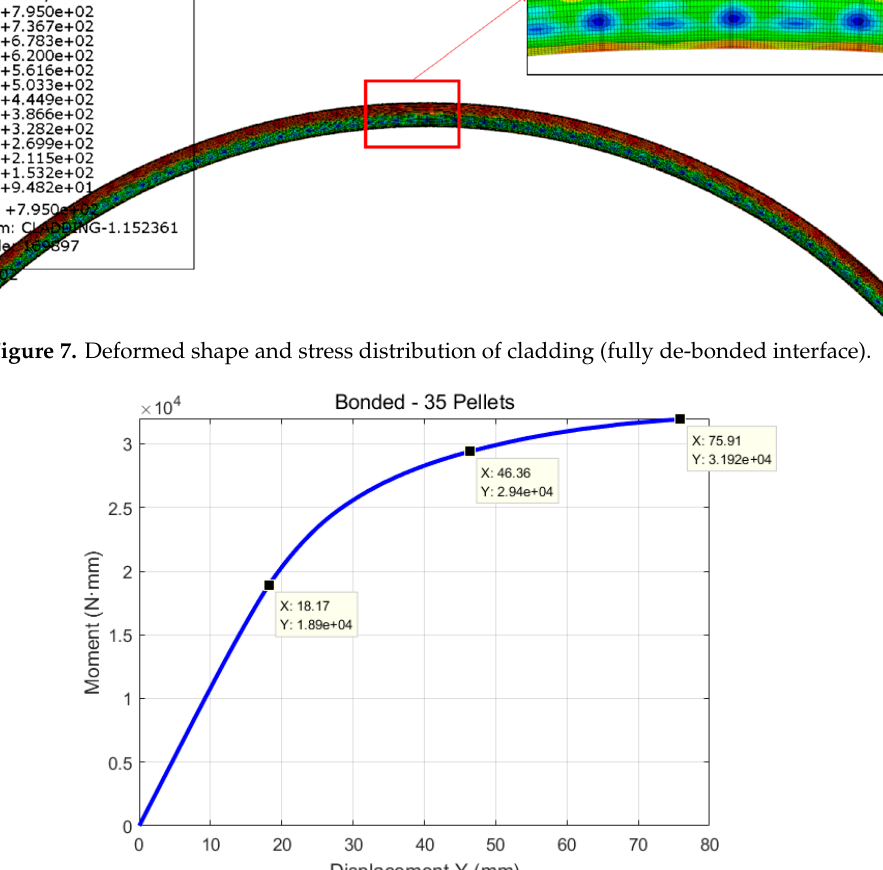
Figure 8. Moment versus maximum displacement diagram (fully bonded case).